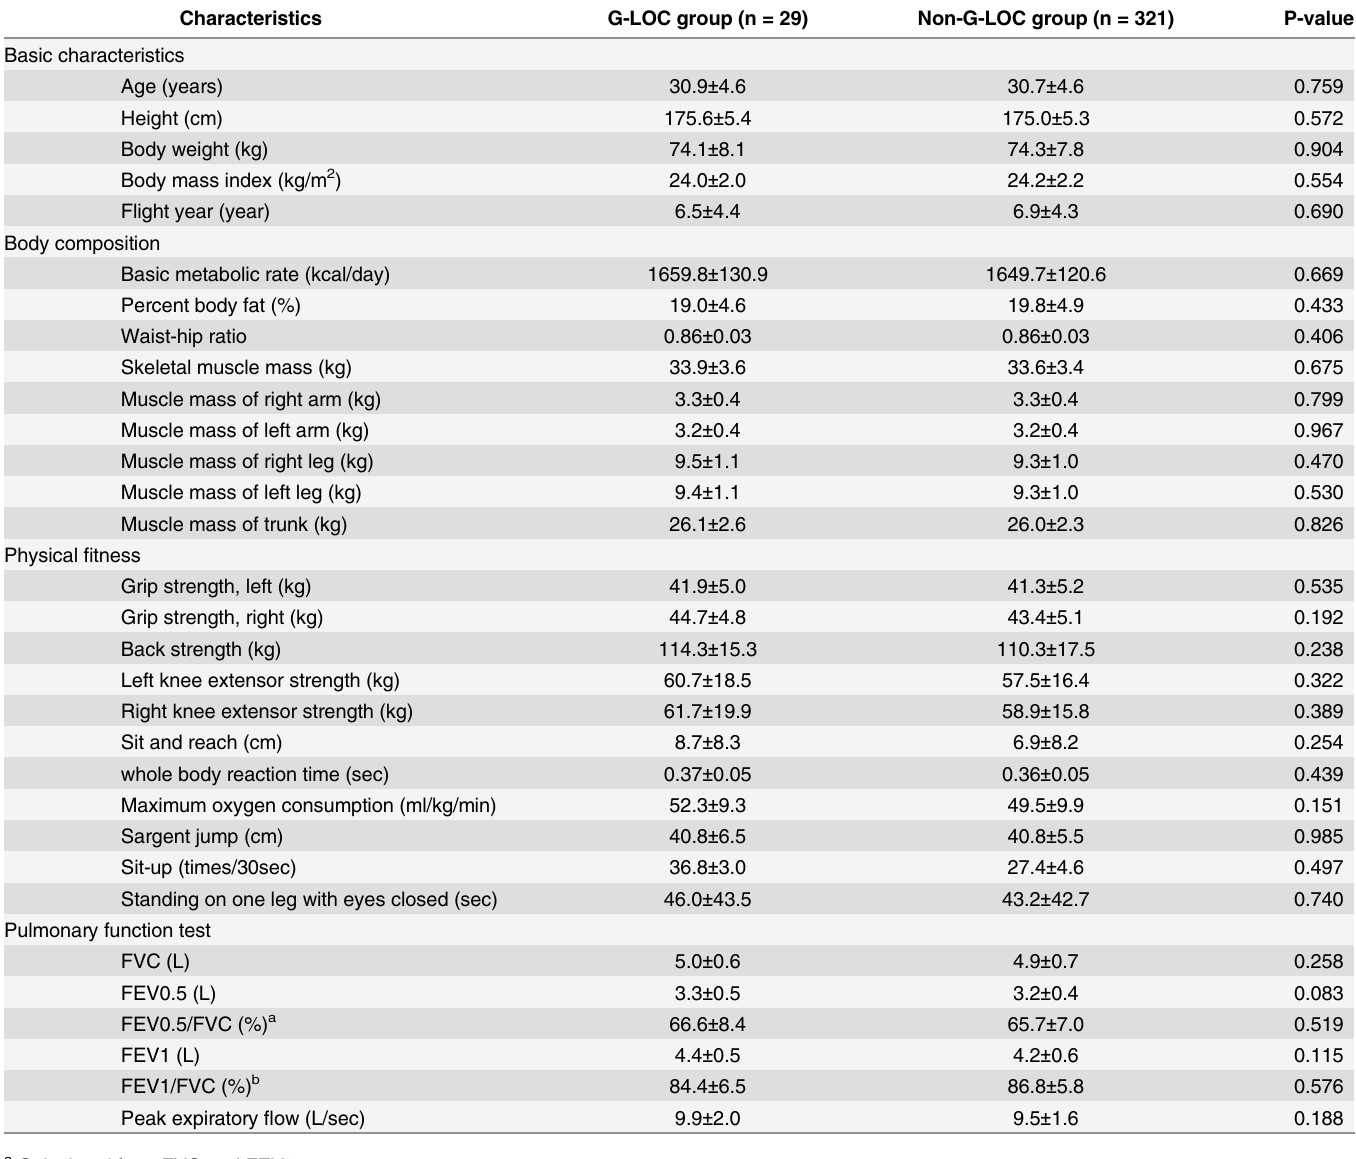
Table 2. Differences between G-LOC group and non-G-LOC group.